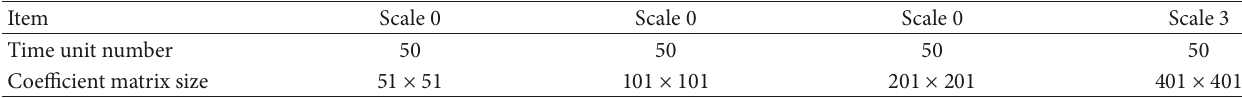
Table 2: Reconstruction parameters in numerical